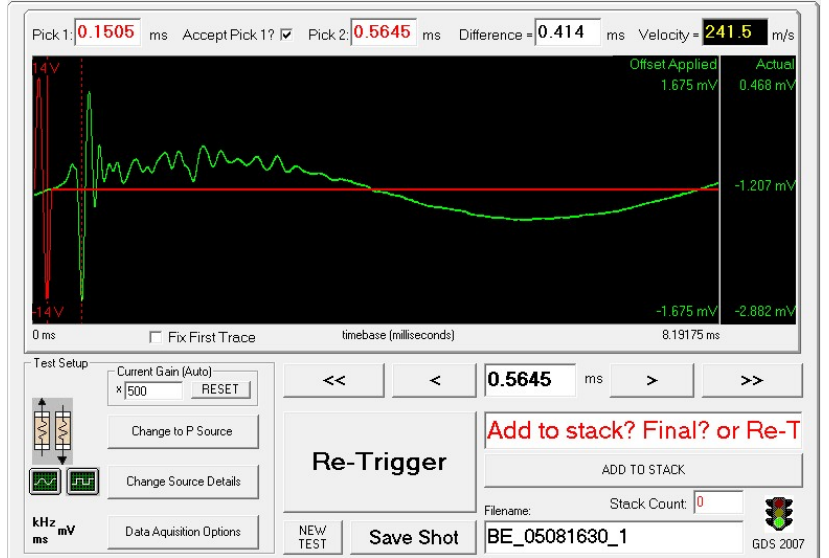
Figure 4. BES software interface display